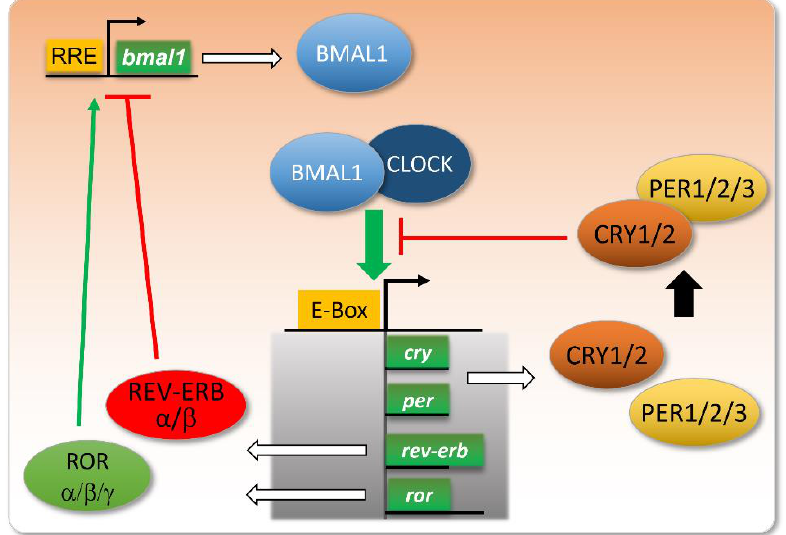
Figure 1. Core clock genes and their intertwined feedback loops.